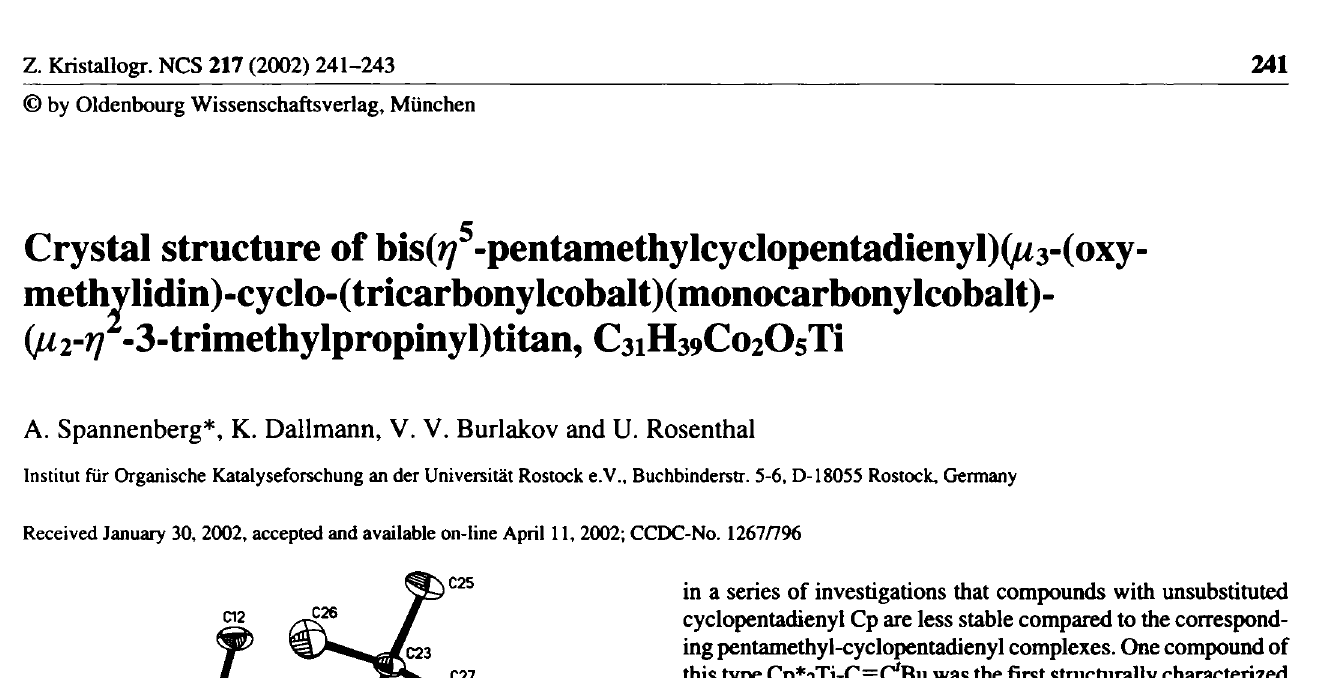
Table 1. Data collection and handling.